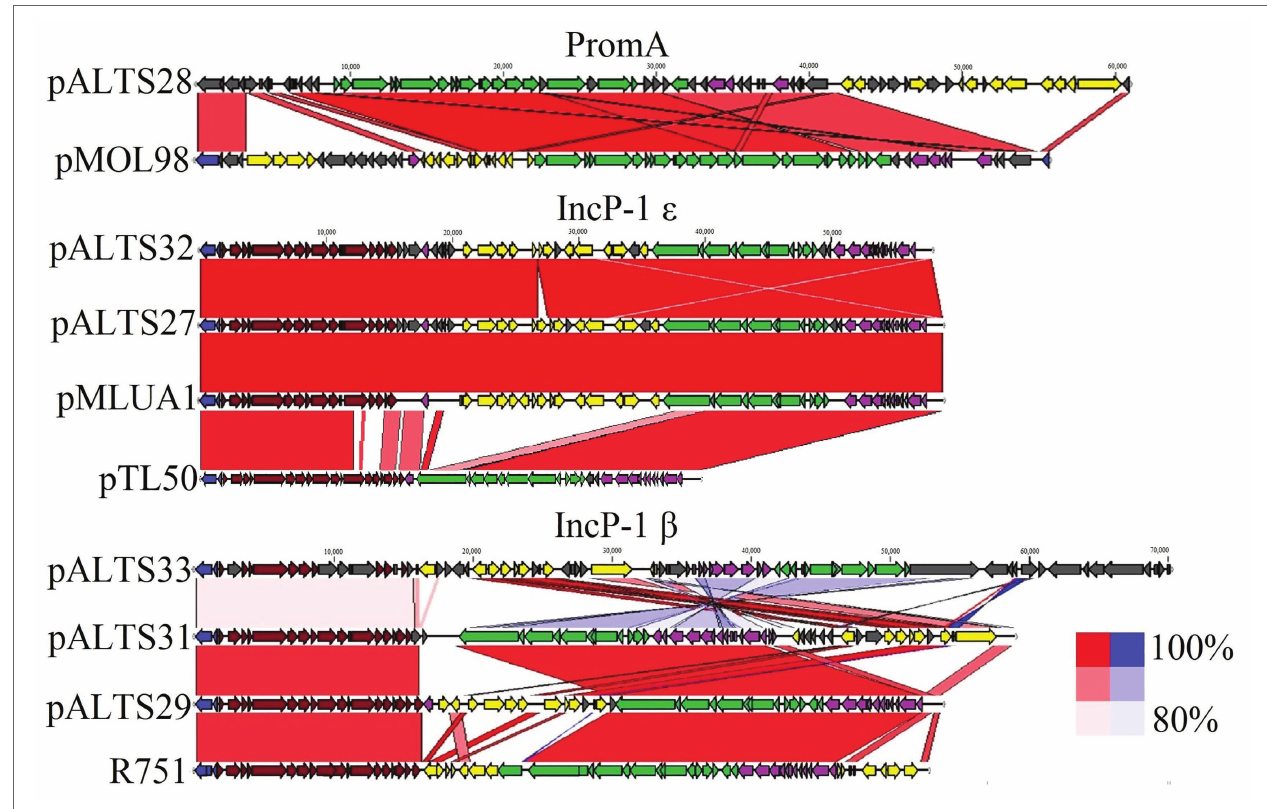
FIGURE 3 | Comparative analysis of the pALTS plasmids with close representatives of their respective plasmid incompatibility group. Alignments of plasmids to representative plasmids in their group show high similarities in backbones. Red alignments represent forward alignment whereas blue alignments represent inverted alignment, and the color intensity is proportional to % similarity. Identity cutoff for visual representation was 80%. The plasmids pMLUA1 and pMOL98 are shown as close relatives of pALTS27/pALTS32 and pALTS28, respectively, while R751 and pTL50 (Shintani et al., 2020) are shown as the respective plasmid archetypes of the IncP-1 β and IncP-1 ɛ groups.